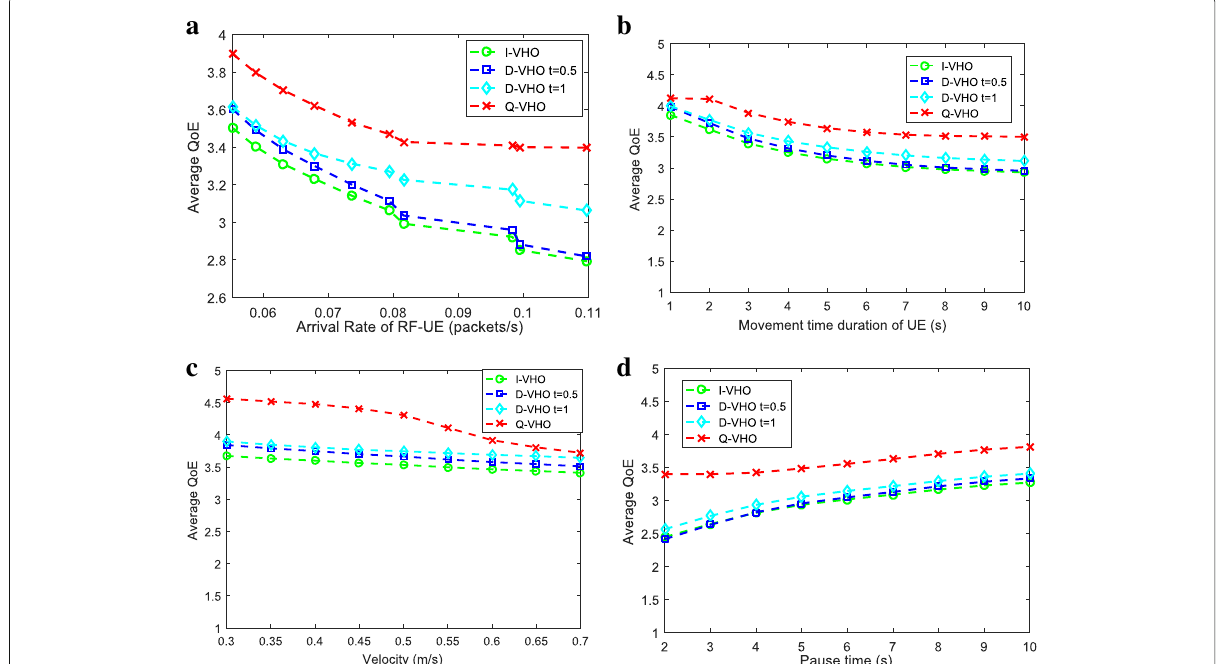
Fig.3 The impact of the a RF-UE arrival rate, b UE movement time duration, c UE velocity, and d and UE pause time on the average QoE